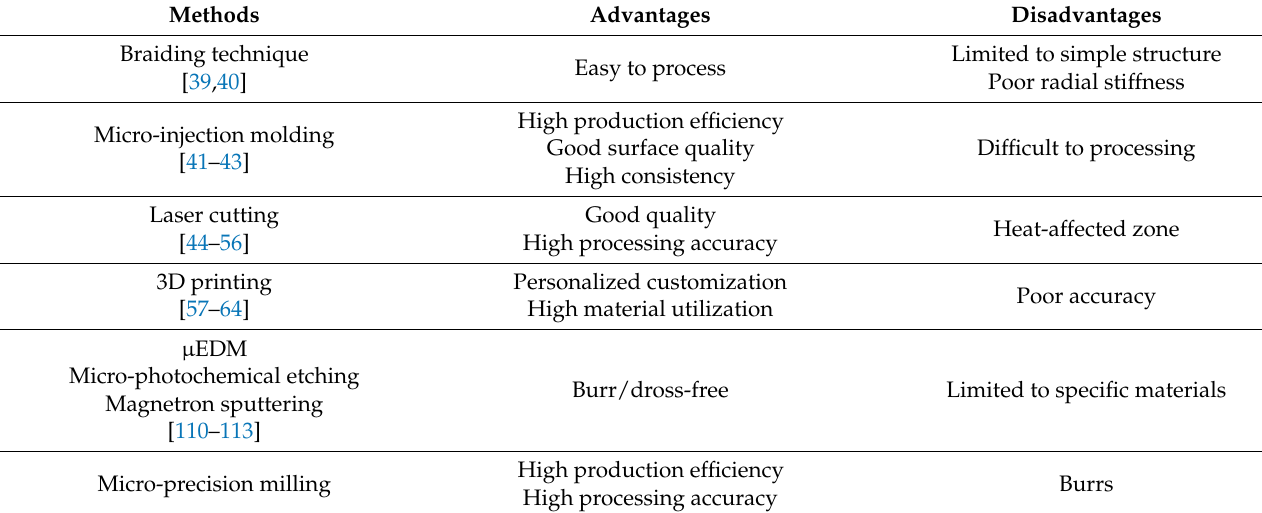
Table 1. Comparison of various manufacturing techniques used in vascular